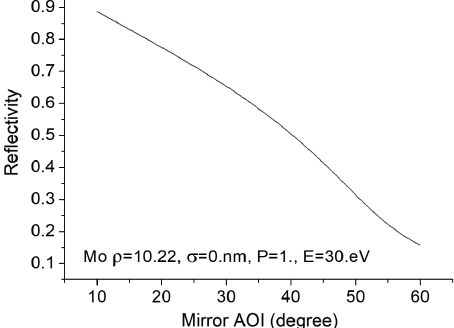
FIG. 13. Reflectivity of a molybdenum mirror for 30 eV photon energy for angles between 10° and